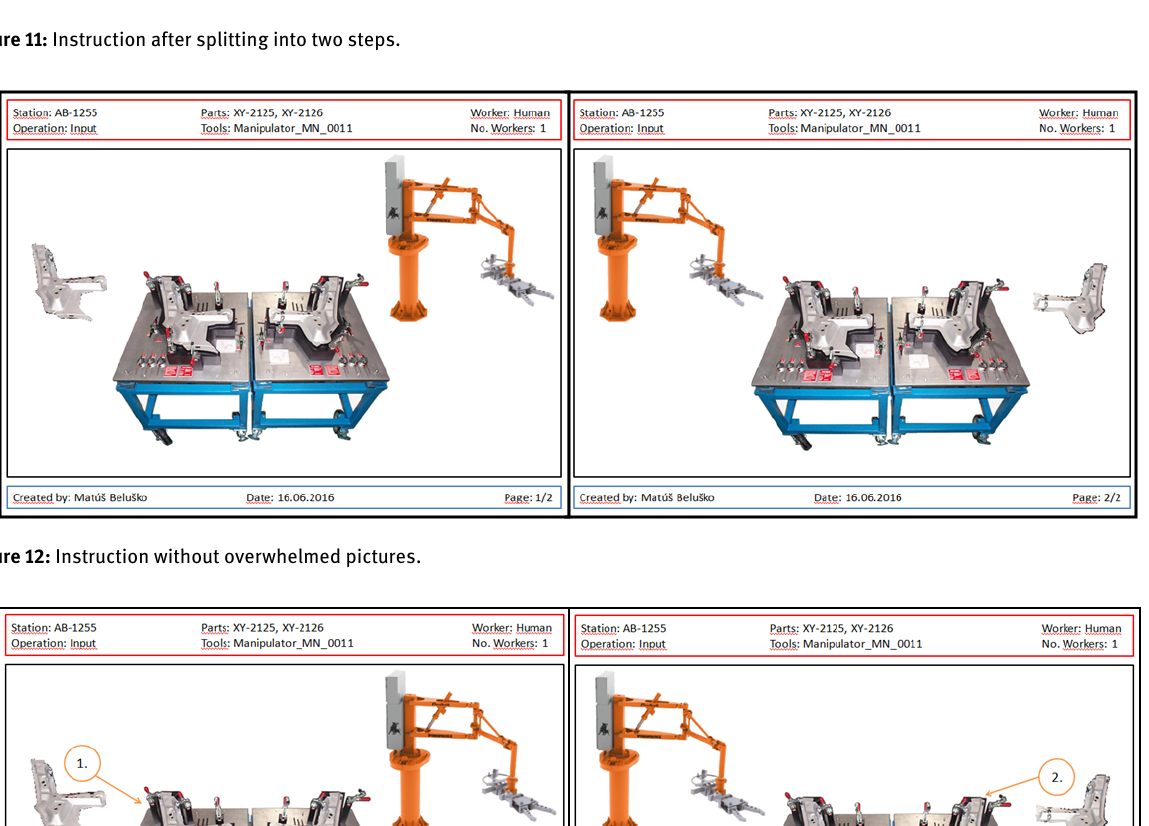
ing of part in fixture are added. At the end, name of parts and tools are added underneath to even fasten the infor- mation gaining process (refer with: Figure